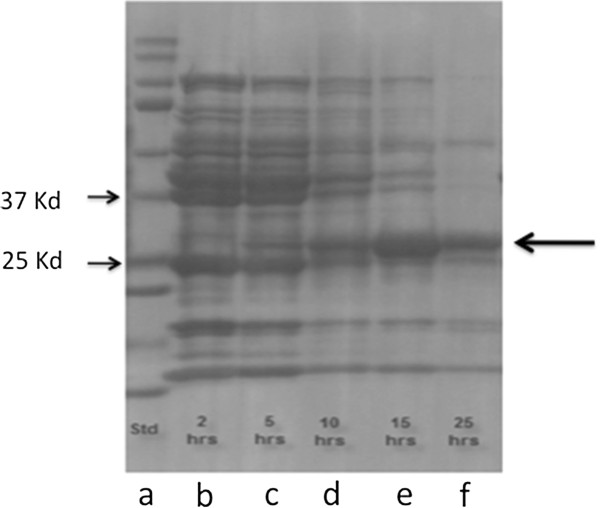
SDS-PAGE of eluted solutions from Ni-NTA columns of cell extracts derived from bioreactor cultures ofE. colistrain BL21 (mHO1) harvested at various times during growth on ZY medium. Gel lanes are: mixture of protein molecular size standards (a), and cell extracts from cultures harvested at 2h, (b), 5h (c), 10h (d), 15h (e) and 25 h (f) after culture inoculation. Expression of 29Kd ho1 is evident (right arrow) and not visible when derived from cells grown without lactose or glucose + IPTG (not shown). Gel positions of 37Kd and 25Kd protein markers are indicated by arrows (left side).